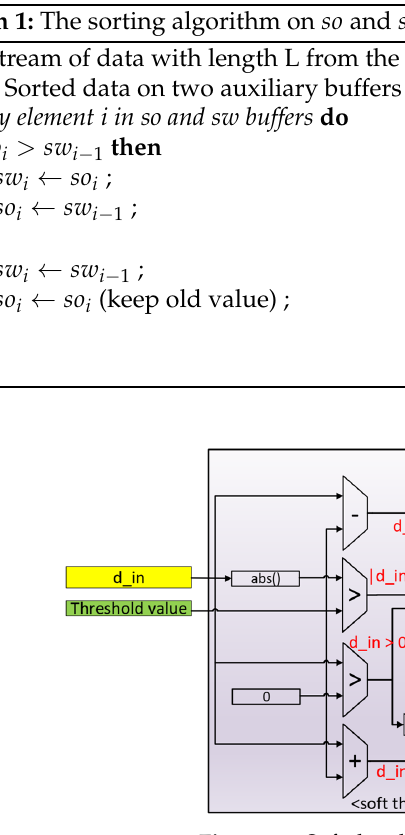
Figure 12. Soft threshold application